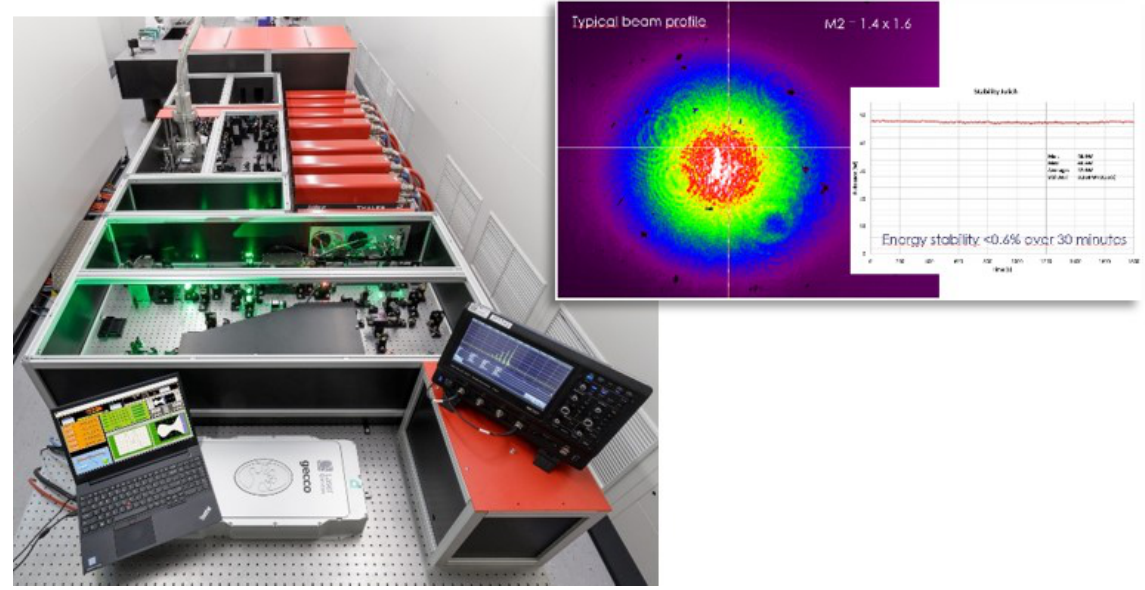
Figure 4: Overview of the 1.3 TW two-stage amplifier built by THALES, consisting of an oscillator (front), the first amplification stage (front), the second amplification stage with cryocooled Ti:Sapphire crystal (middle left), eight pump lasers (middle right, red) and the compressor unit (far side).The typical beam profile and output energy stability are shown on the right.